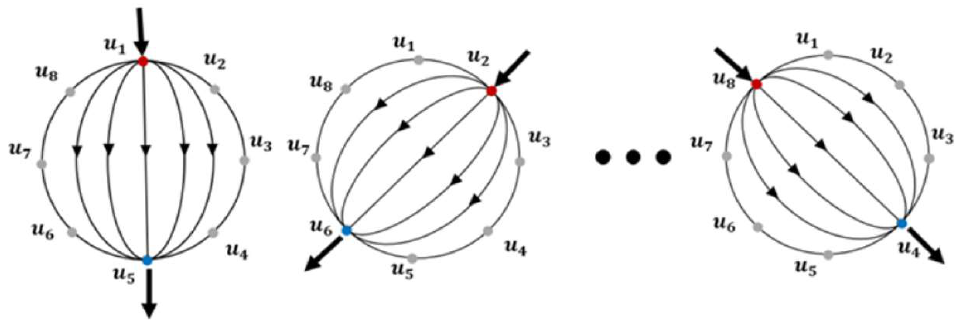
Figure 5. The opposite current excitation strategy: an electrical current flows through the sensitive